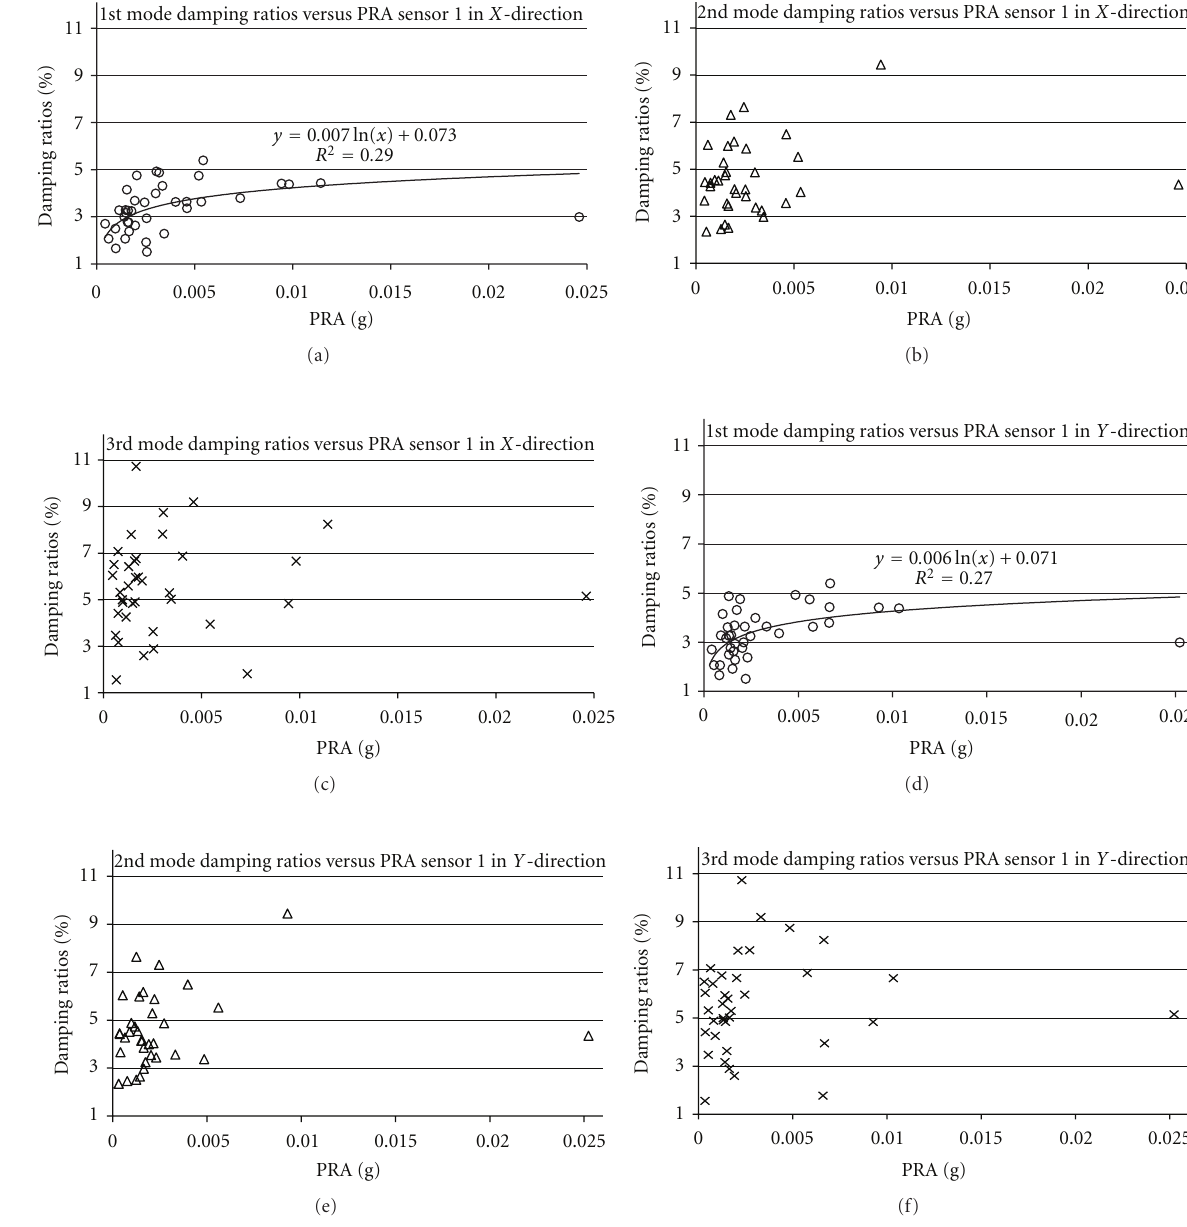
Figure 18: Modal damping ratios of building B for flexible base case: (a) 1st mode, (b) 2nd mode, (c) 3rd mode versus X -direction PRA of sensor 1; (d) 1st mode, (e) 2nd mode, and (f) 3rd mode versus Y -direction PRA of sensor